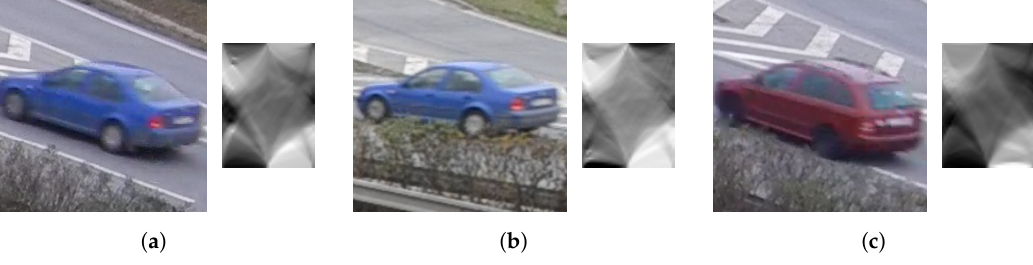
Figure 9. Samples of the dataset prepared using the data presented in [66]. Vehicle images are cropped to square, and transformed using the MDIPFL projection mapping. Subfigures ( a , b ) represent different observations of the same instance. Subfigure ( c ) shows a sample of a different instance.